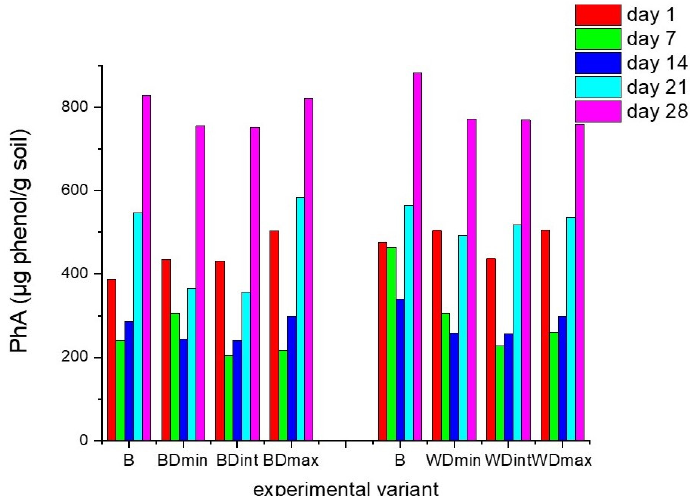
Figure 3. Soil phosphatase activity (PhA) for each experimental variant, determined every 7 days for 28 days: B—seeds untreated with triticonazole, BDmin, and WDmin—barley and wheat seeds treated with the minimum dose, DBint, and WDint—barley and wheat seeds treated with the intermediate dose, BDmax, and WDmax—barley and wheat seeds treated with the maximum dose of